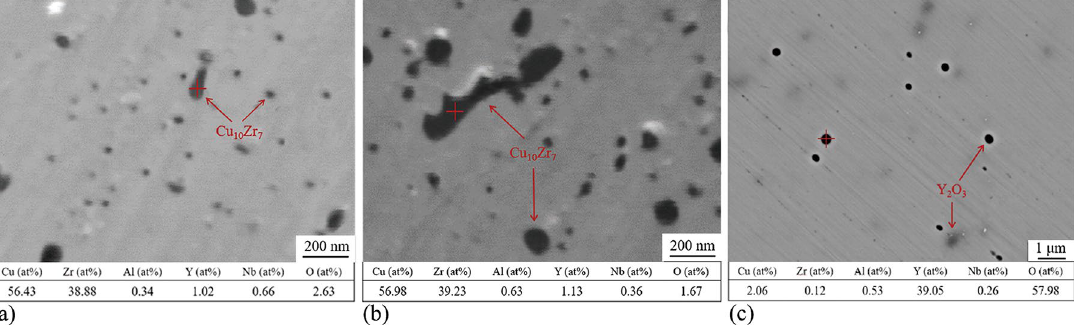
Zr Al ) Y Nb alloys after annealing: 47 45 8 97.5 1.5